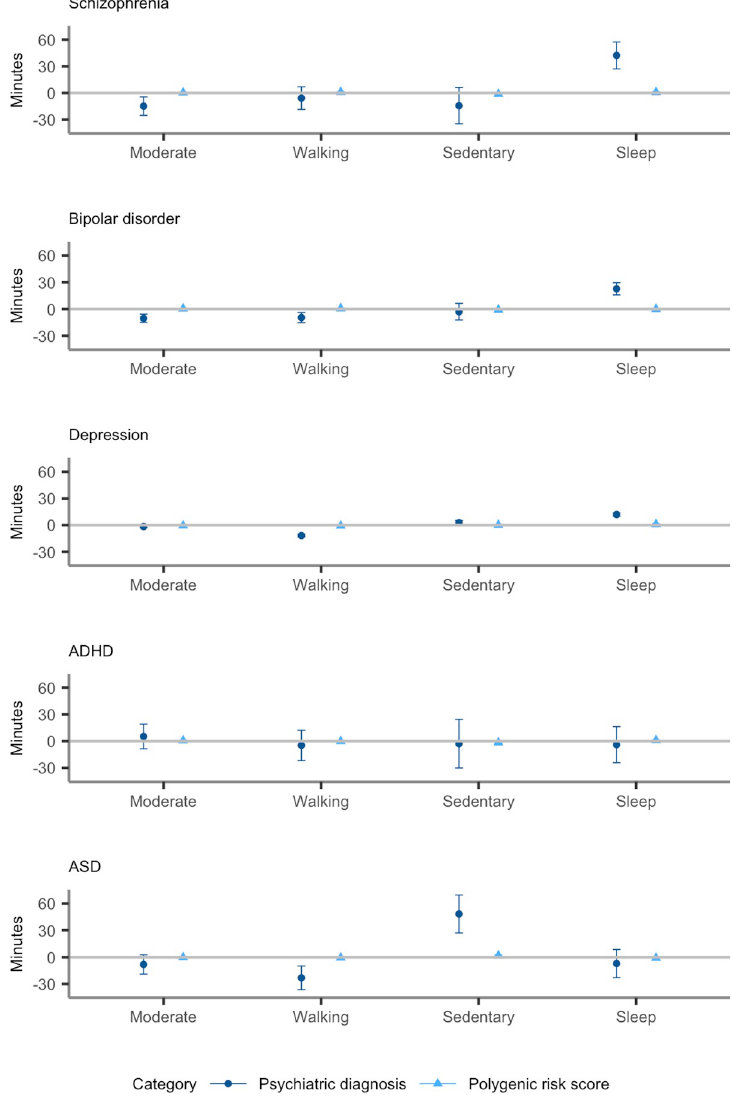
Fig 2. Associations between type of activity in minutes and diagnoses of, and PRS for, each psychiatric disorder. Error bars indicate 95% confidence intervals. A beta of 1 is equivalent to a 1 standard deviation (SD) change in level of activity between individuals with and without a psychiatric disorder or per 1 SD increase in PRS. We excluded individuals with a psychiatric disorder for PRS